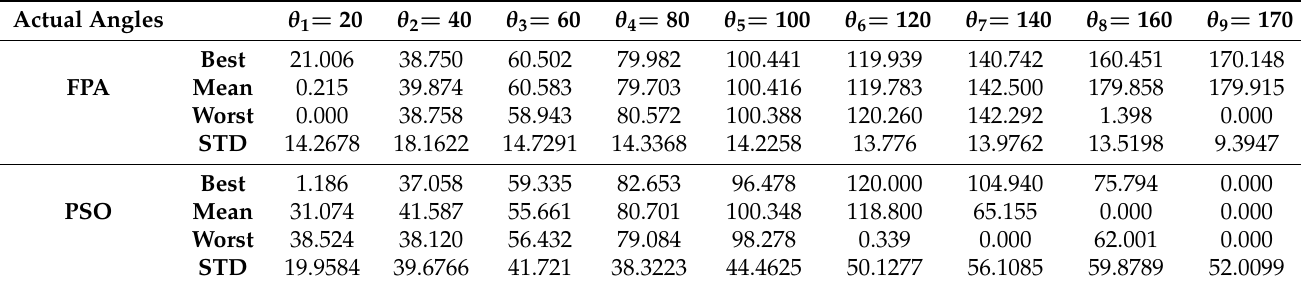
Table 4. Estimation accuracy and STD for nine targets at SNR = 0 dB.